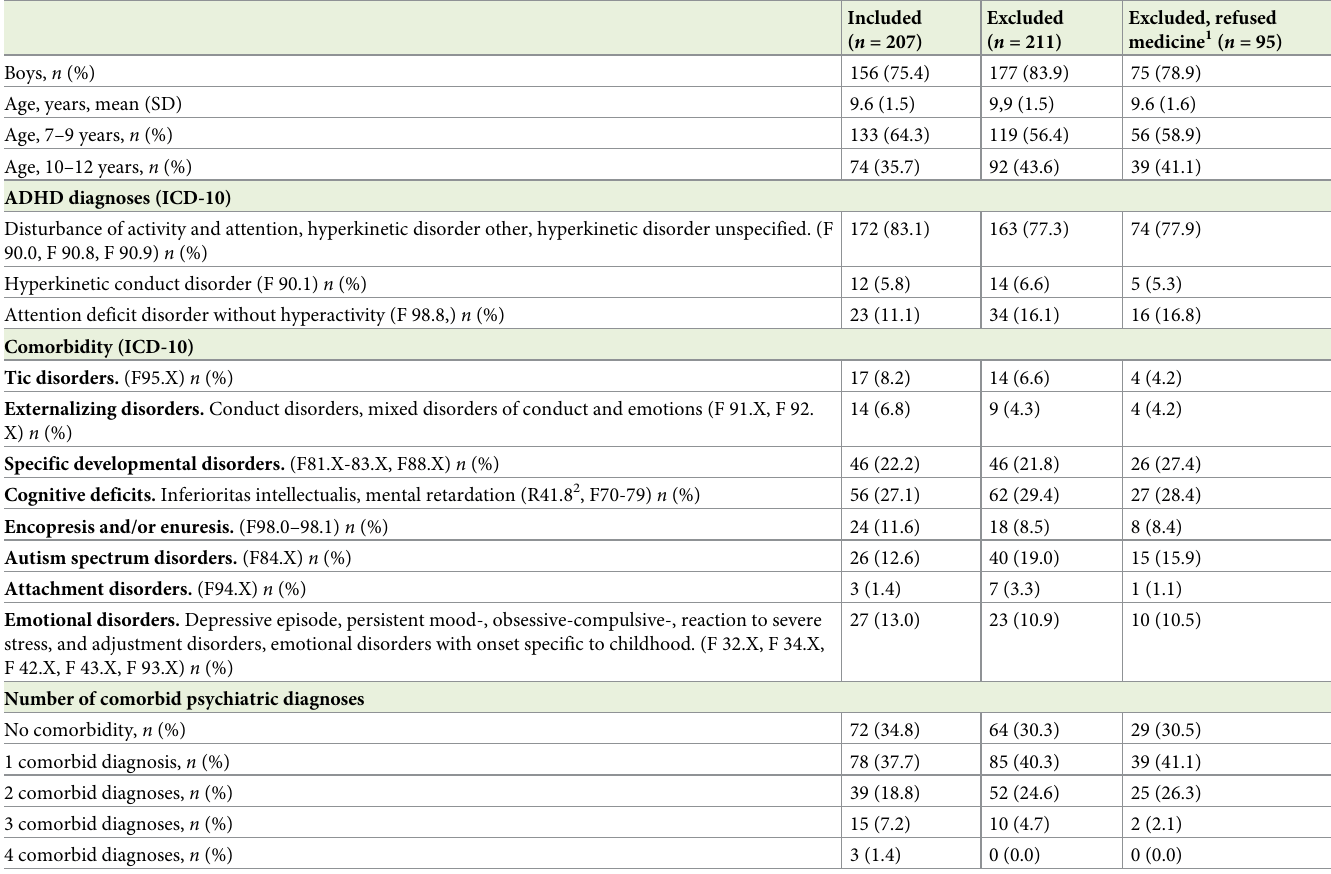
Table 1. Characteristics of included and excluded patients at study